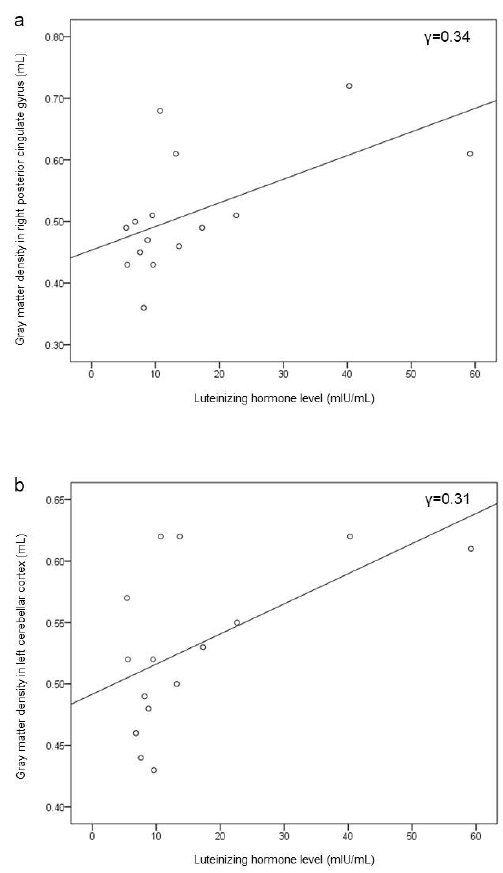
Figure 3. Scatterplot of correlation between LH level and increased GM; PCgG (MNI x, y, and z coordinates 3, − 48, and 21) ( a ) and Cb ( − 23, − 69, − 47) ( b ) in ICPP girls. Each correlation coefficient is 0.57 ( p * = 0.03) and 0.53 ( p * = 0.04) in PCgG and Cb. * p value is uncorrected on this model.